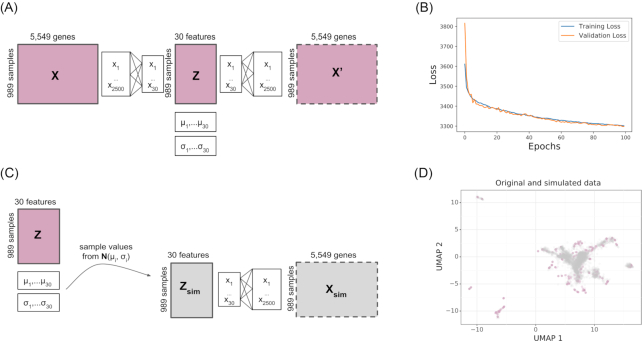
Simulating gene expression data using VAE. (A) Architecture of the VAE, where the input data get compressed into an intermediate layer of 2,500 features and then into a hidden layer of 30 latent features. Each latent feature follows a normal distribution with mean µ and variance σ. The input dimensions of the P. aeruginosa dataset are shown here as an example (989 samples, 5,549 genes). The same architecture is used to train the recount2 dataset except the input has 896 samples and 58,037 genes. (B) Validation loss plotted per epoch during training using the P. aeruginosa compendium. (C) Workflow to simulate gene expression samples from a compendium model, where new samples are generated by sampling from the latent space distribution. (D) UMAP projection of P. aeruginosa gene expression data from the real dataset (pink) and the simulated compendium using the workflow in C (grey).